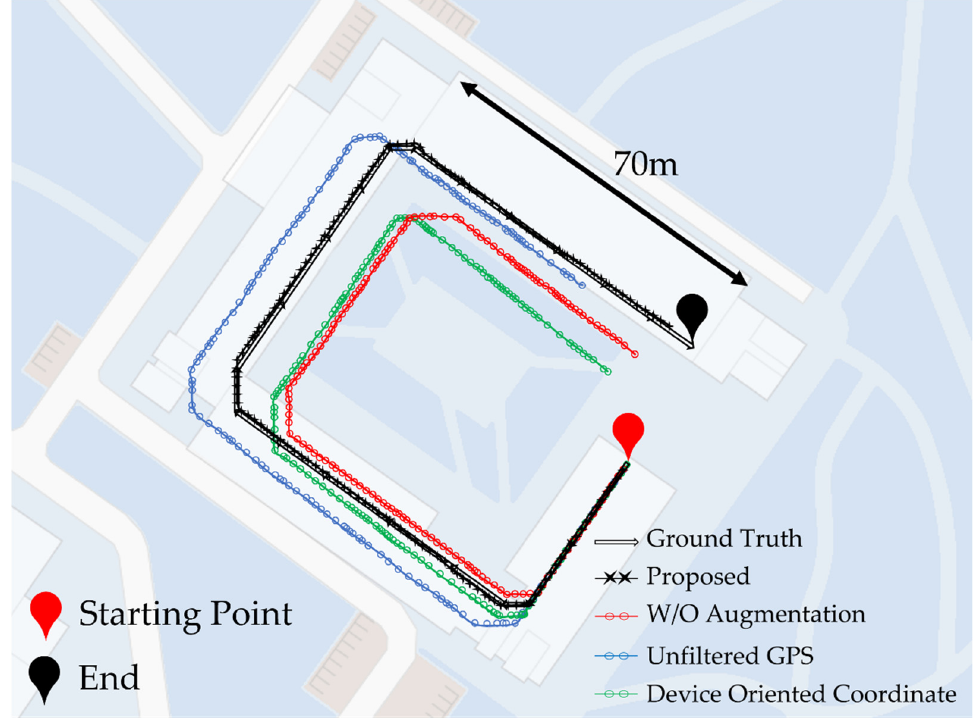
Figure 13. Indoor localization result. Table 5. Positioning error for each method at every epoch.